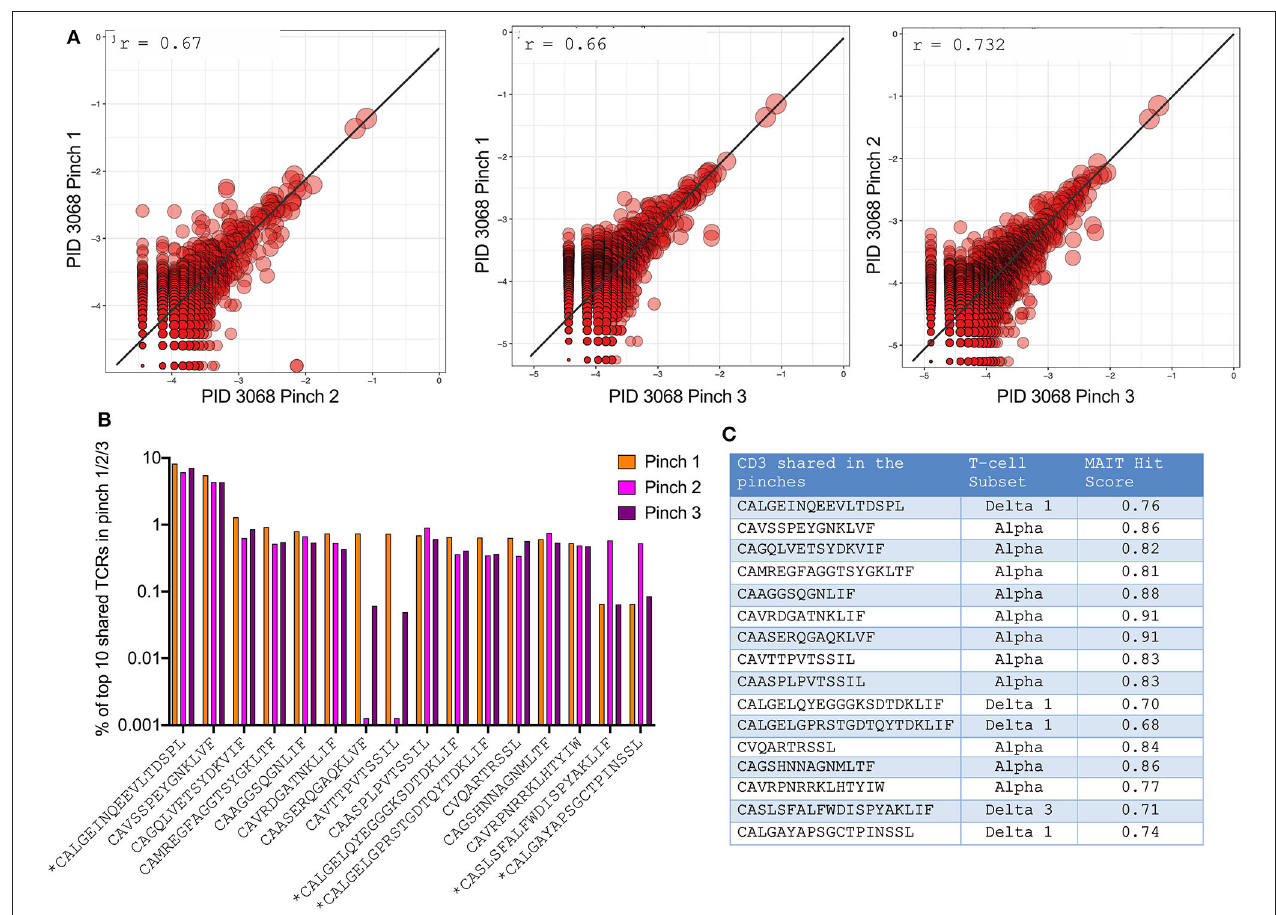
FIGURE 5 | High reproducibility of TCR sequences between singular duodenal pinch biopsies. (A) Pearson correlation of TCR sequences obtained from three duodenal pinches of PID 022-09-3068 (participant is HIV –ve; Supplementary Table 1 ). (B) Frequency of the most abundant TCR sequences shared between the three pinches with * denoting δ (delta) T-cell subset. (C) Corresponding T-cell subsets to obtained CDR3 sequences that were shared between the 3 duodenal pinches as illustrated in (B) , MAIT hit score from (http://www.cbs.dtu.dk/services/MAIT_Match/) was used to identify additional TCRs with MAIT-like